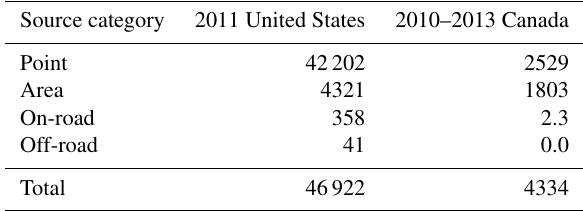
Table 5. Sum of source-sector-specific mercury emissions (kg) for the 2011 United States inventory (version 1) and the 2010–2013 Canadian